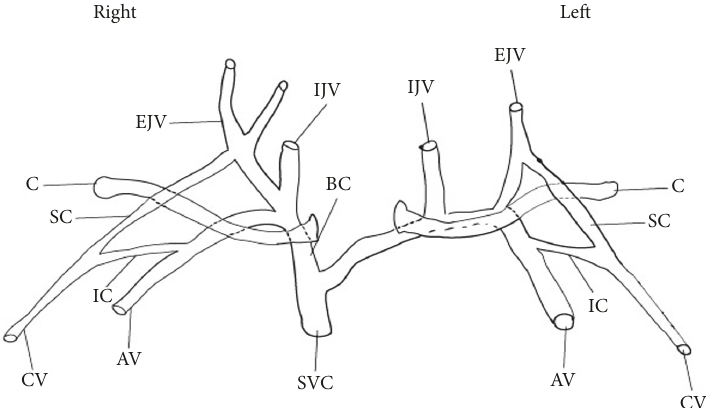
Figure 3: Schematic diagram showing the clavicle (C), the internal jugular vein (IJV), external jugular vein (EJV), supraclavicular (SC) branches of cephalic vein, cephalic vein (CV), infraclavicular (IC) branches of cephalic vein, axillary veins (AV), brachiocephalic vein (BC), and superior vena cava